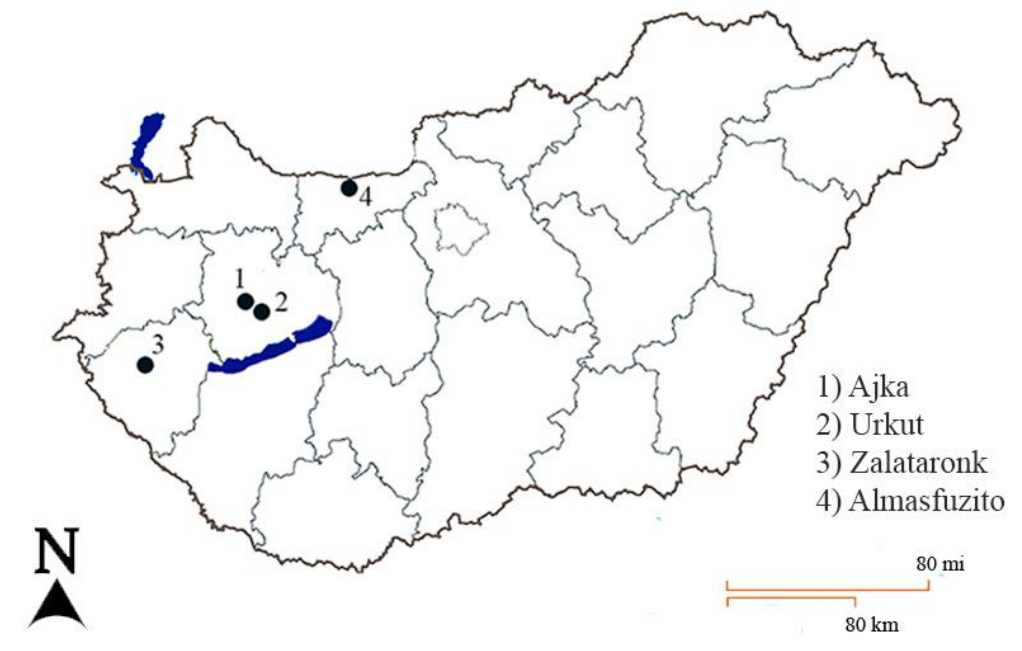
Figure 1. Map of Hungary presents the five investigated depositories.